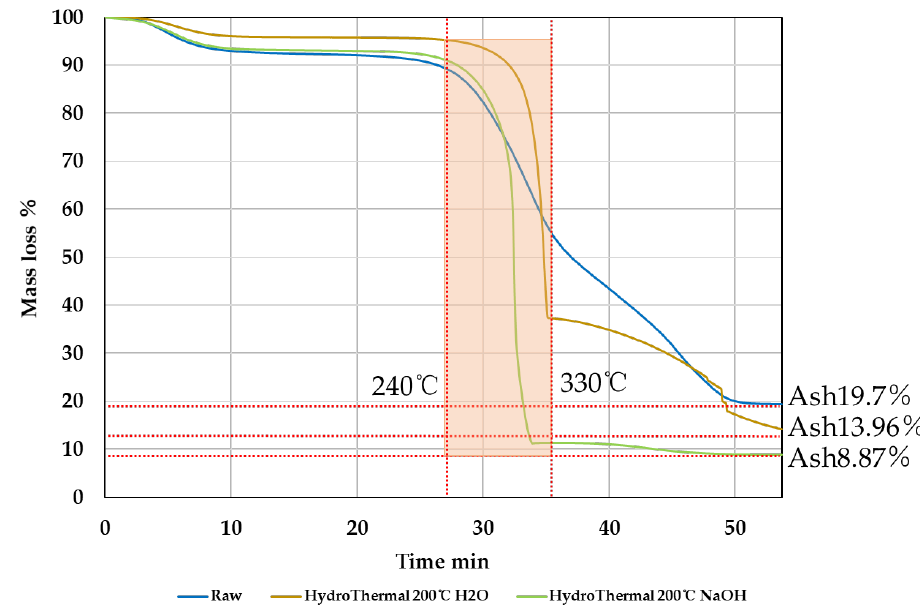
Figure 14. TG analysis results of the rice husk hydrothermal products.